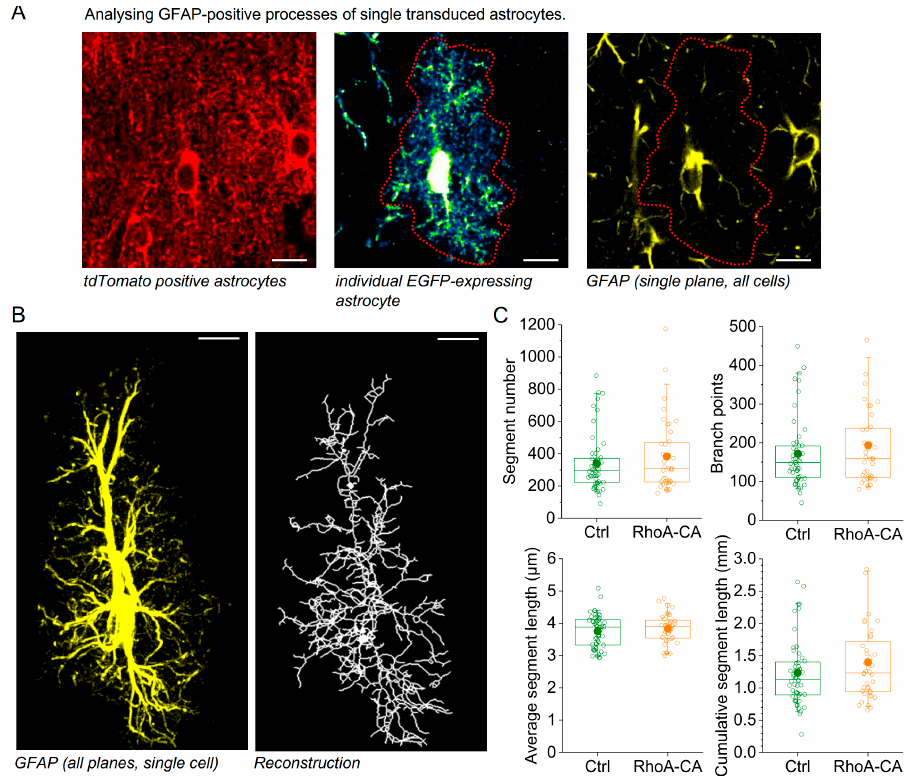
Figure 5. Increasing astrocytic RhoA activity does not affect larger, GFAP-positive processes. ( A ) Illustration of the experimental approach. Astrocytes in mice with sparse hippocampal EGFP expression were transduced using control and RhoA-CA–expressing rAAVs (hGFAP-tdTomato and hGFAP-tdTomato-RhoA-CA) (left panel). Isolated transduced and EGFP-expressing astrocytes were identified, and their boundaries were determined using their EGFP-fluorescence throughout an image stack (middle panel, single plane example, boundary indicated by dotted red line). Right panel: Example of GFAP immunohistochemistry of the section shown in the left and middle panel